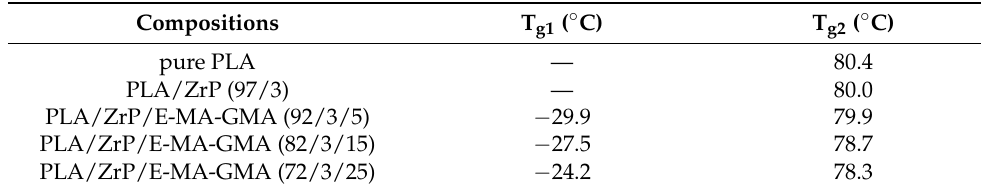
Table 1. T g of pure PLA, PLA/ ZrP and PLA/ZrP/E-MA-GMA nanocomposites tested by DMA.